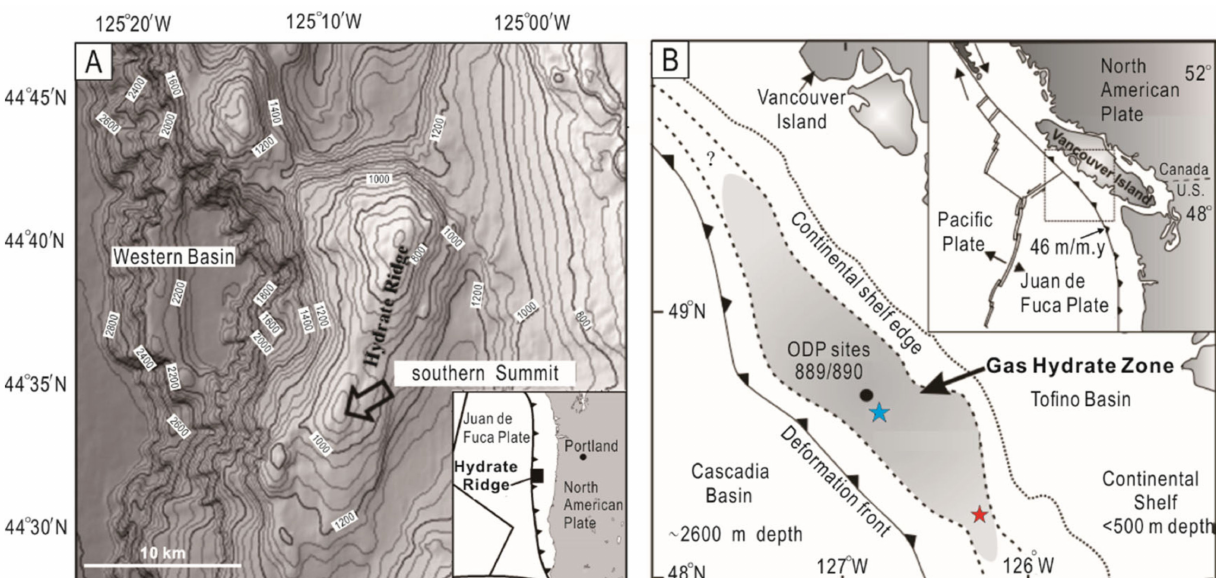
Figure 19. ( A ) Regional map of Hydrate Ridge (large box) and the Cascadia margin (small box). ( B ) Locations of the Bullseye cold vent (blue star) and Barkley Canyon site (red star). The gray shading represents the approximate area in which hydrates occur according to the distribution of BSRs. ( A is modified from [109,112]; B is modified from